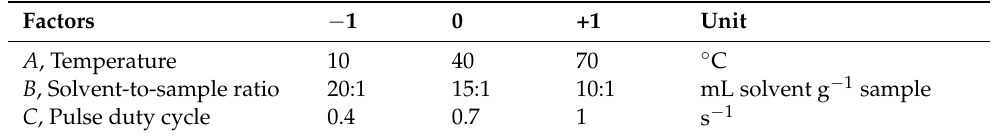
Table 1. Independent factors and their levels.